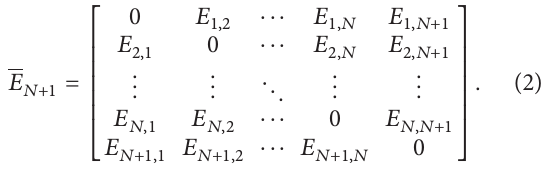
Figure 1: The basic structure of an expanded system.